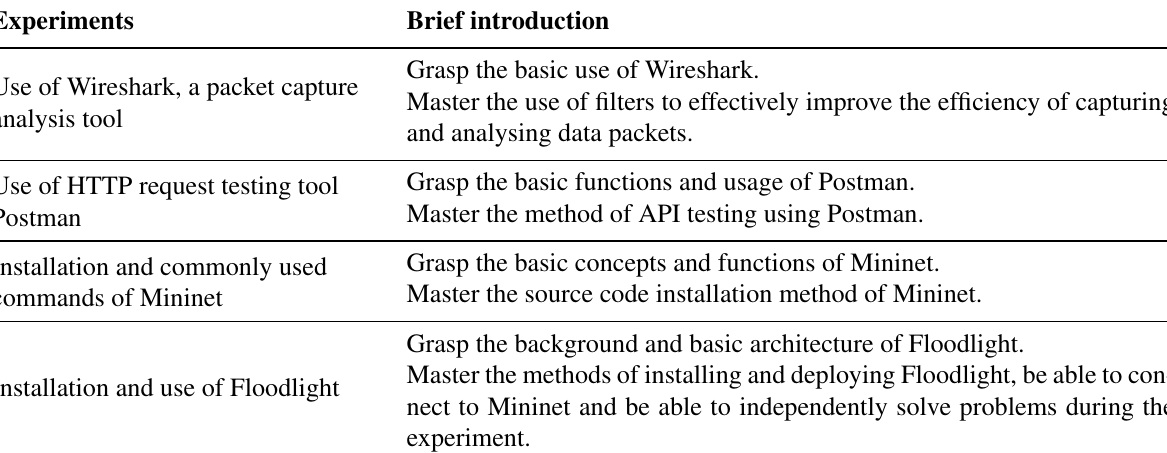
Table 1 Basic experimental